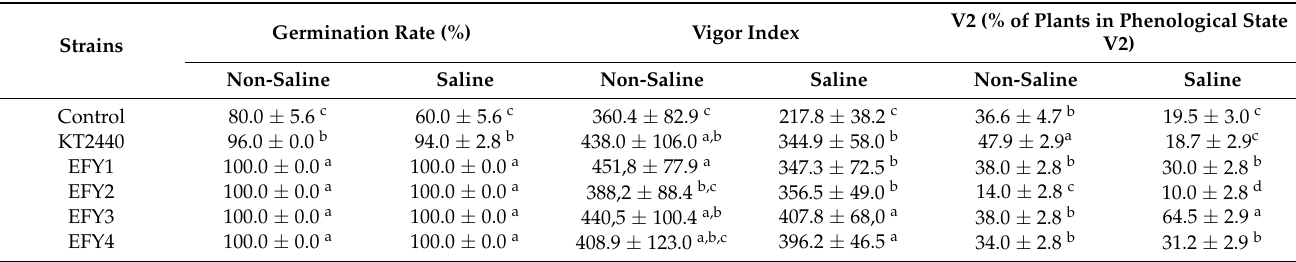
Table 4. Germination rate (%), vigor index, and percentage of soybean plants in phenological stage V2 after 21 days of growth under non-saline and slightly saline soils.